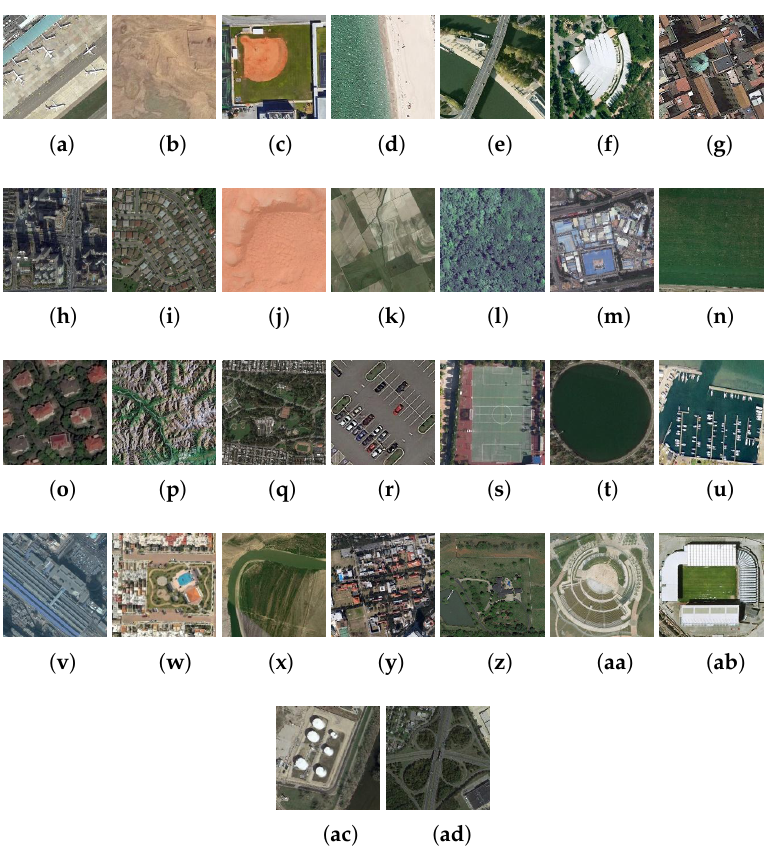
Figure 7. Image classes in the AID dataset: ( a ) airport; ( b ) bare land; ( c ) baseball field; ( d ) beach; ( e ) bridge; ( f ) centre; ( g ) church; ( h ) commercial; ( i ) dense residential; ( j ) desert; ( k ) farmland; ( l ) forest; ( m ) industrial; ( n ) meadow; ( o ) medium residential; ( p ) mountain; ( q ) park; ( r ) parking; ( s ) playground; ( t ) pond; ( u ) port; ( v ) railway station; ( w ) resort; ( x ) river; ( y ) school; ( z ) sparse residential; ( aa ) square; ( ab ) stadium; ( ac ) storage tanks; ( ad )